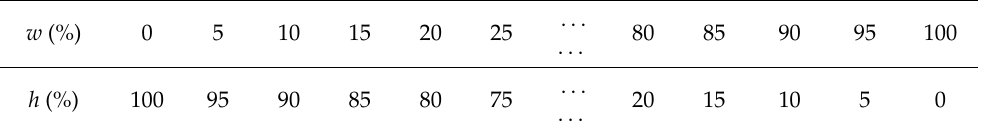
Table 2. Partial values of the proportion p